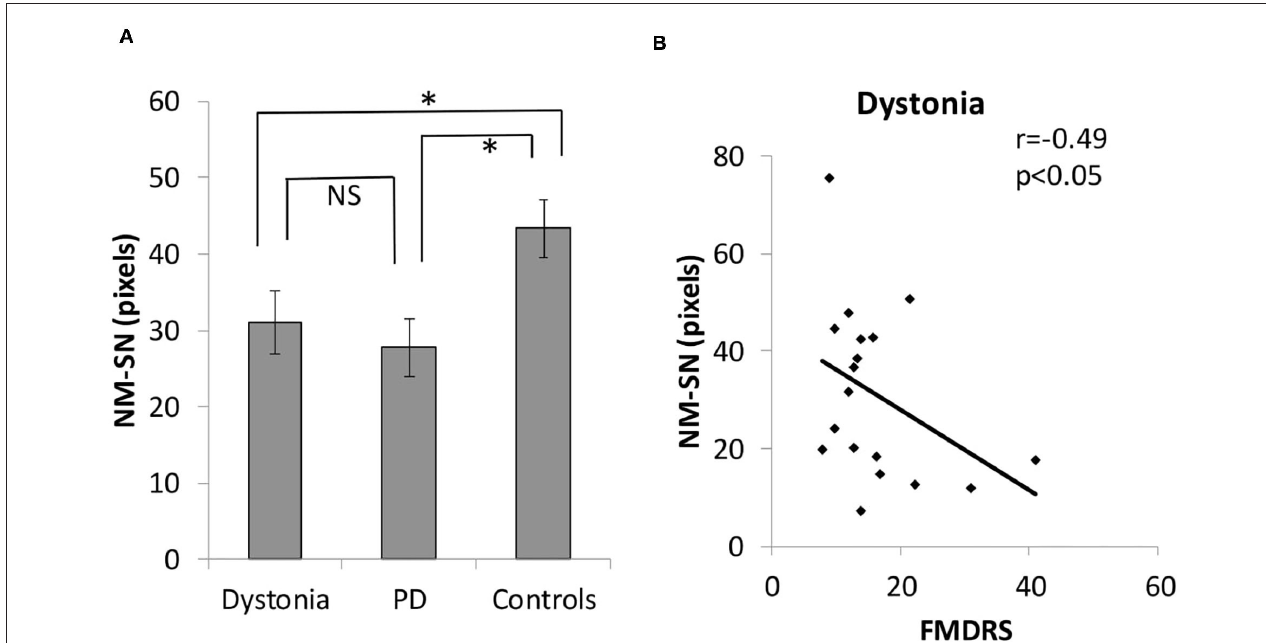
FIGURE 2 | (A) Comparison of the positive NM-SN area in patients with dystonia, patients with PD, and healthy controls. (B) Correlation between the FMDRS and the NM-SN area in patients with dystonia. Error bars indicate SEM. *Statistically significant difference ( p < 0.05). NM-SN, neuromelanin-substantia nigra; FMDRS, Fahn-Marsden Dystonia Rating Scale; NS, non-significant; PD, Parkinson’s disease; SEM, standard error of the